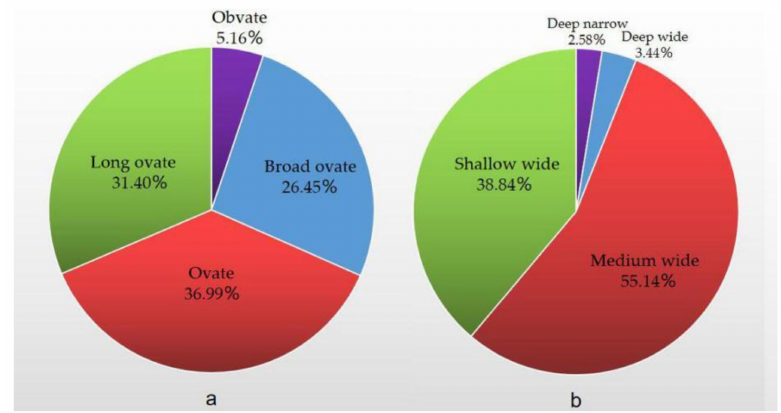
Figure 2. The distribution of leaf morphology in the hybrids. ( a ) Distribution of leaf blade shape in hybrid progeny; ( b ) distribution of leaf lobe shape in hybrid